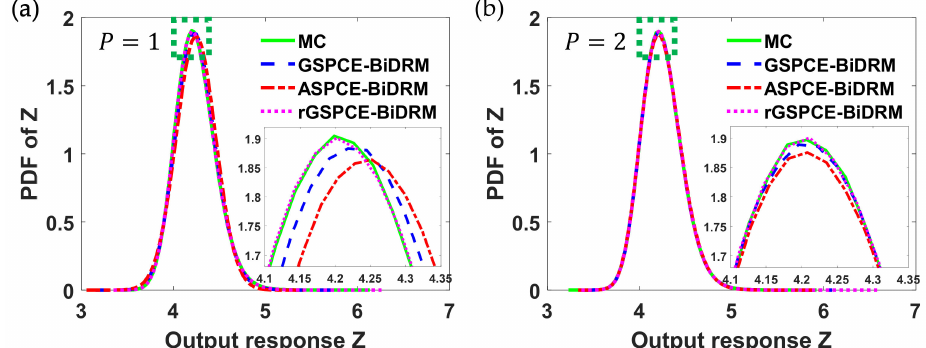
Figure 2. Simulation results of the probability density function (PDF) of Z with different polynomial orders ( P ) in each case study: ( a ) P = 1 and ( b ) P = 2.